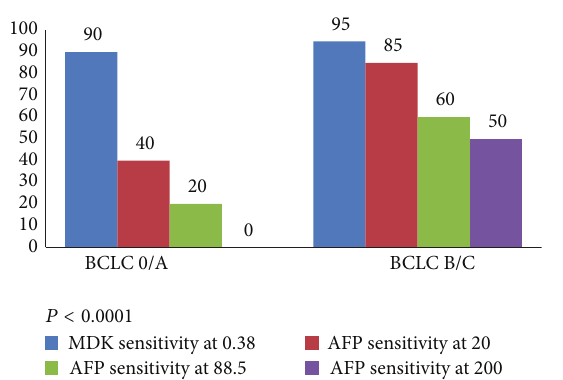
Figure 2: Sensitivity of MDK and AFP in diagnosis of HCC from CLD patients according to BCLC stage.